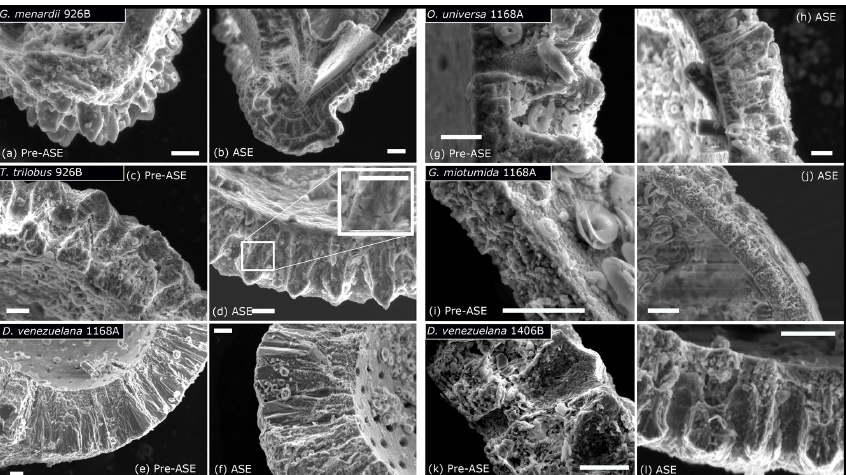
Figure 2. SEM images assessing impact of ASE treatment on microstructural preservation of foraminifera. (a) Pre-ASE G. menardii from 926B show signs of etching and the loss of fine detail in some samples, while ASE-treated specimens (b) have laminations preserved, although etching across the test wall is present. (c) Pre-ASE T. trilobus from 926B are also etched, with some rough inner surfaces and the loss of fine features between calcite layers, while these appear better preserved in samples from the ASE treatment, with the inset showing a higher-magnification view of fine cross-sectional structural details (d) , though note the loss of pores on the inner surface of ASE-treated T. trilobus , indicating mineral overgrowth. (e) D. venezuelana from 1168A pre-ASE treated and (f) ASE treated. In both, the inner surface is smooth with no etching, and the outer calcite crust is well-preserved. Some slight etching of laminar calcite is visible. (g) O. universa from 1168A pre-ASE treated and (h) ASE treated. Etching visible in test cross section for both, as well as pitting in pre-ASE pore surface, though inner trochospiral form is preserved in both samples (not shown). (i) Pre-ASE-treated G. miotumida from core 1168A and (j) ASE treated. As for the O. universa , etching is visible across the test wall. (k) D. venezuelana from 1406B, pre-ASE treated and (l) ASE treated. Etching and pitting visible in both, although fine features such as layers are preserved. All scale bars shown are 10µm.